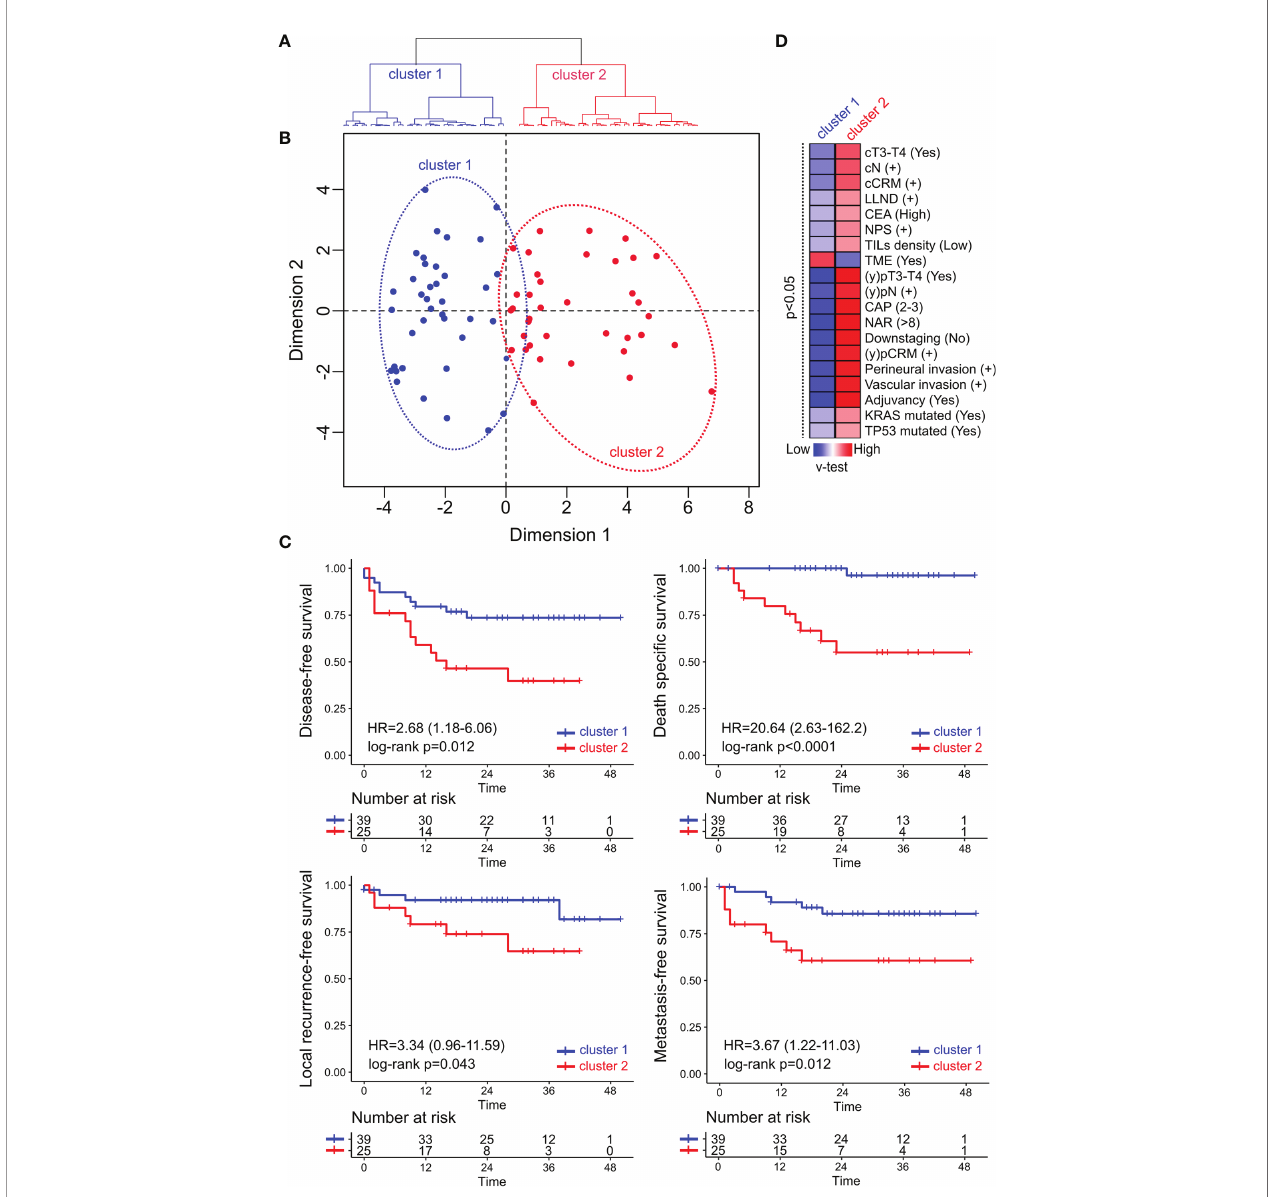
FIGURE 5 | Multivariate and unsupervised analysis of clinicopathological, immune and mutational markers of the non-metastatic RC cohort. (A) The seventy-six patients were segregated into two classes: cluster 1 (in blue) and cluster 2 (in red) based on the fi rst bifurcation of the dendrogram produced by the hierarchical clustering partitioning analysis of samples. (B) Multidimensional scaling plot showing the euclidean distance of each sample from each other determined by their similarities in the included variables. (C) Univariate Kaplan – Meier survival analysis RC cases according to their assigned cluster. Survival analysis revealed that cluster 2 was particularly associated with shorter disease-free survival, death-speci fi c survival, local recurrence-free survival, and metastasis-free survival compared with cluster 1. (D) Heatmap of the signi fi cant statistical variables (p <0.05) that contributes with clusters discrimination based on positive (in red) and negative (in blue) v- test